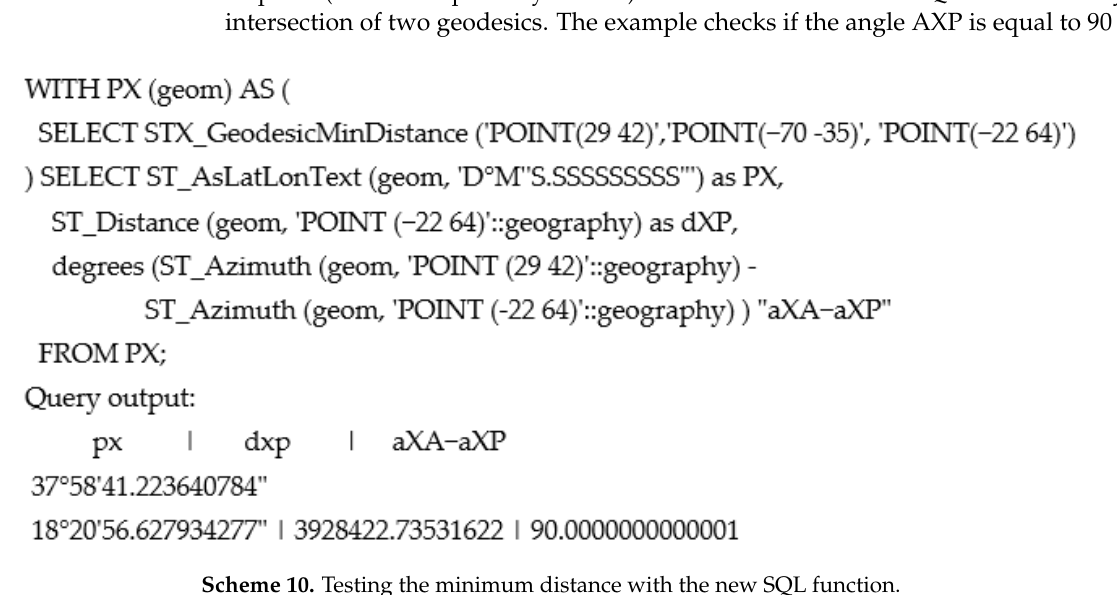
Figure 4. Distance deviations (X’X’’ and PP’’).